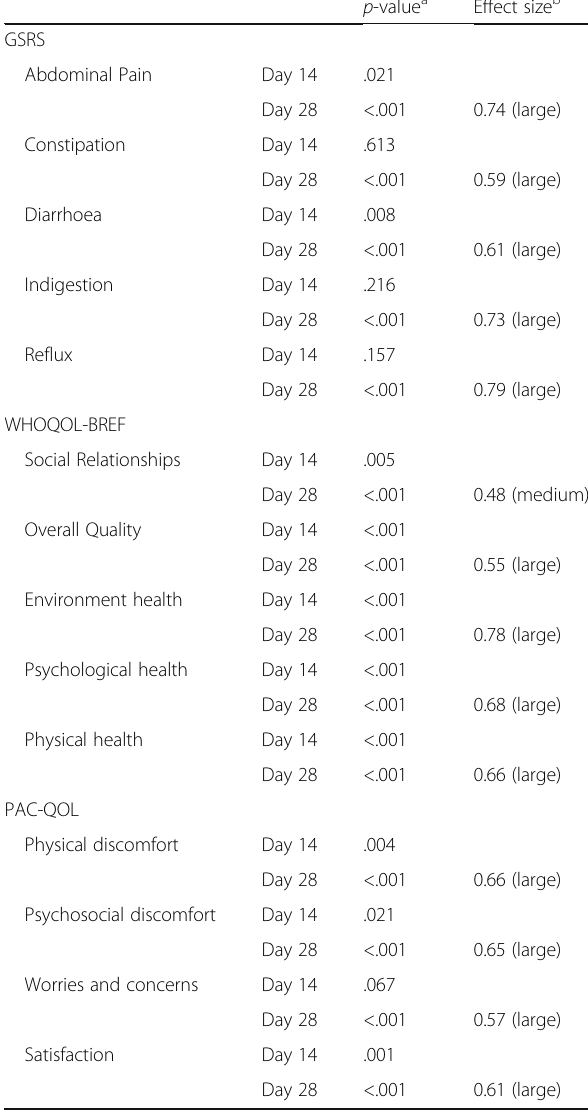
Table 3 Between group significance values at days 14 and 28 and overall effect sizes (Independent Samples